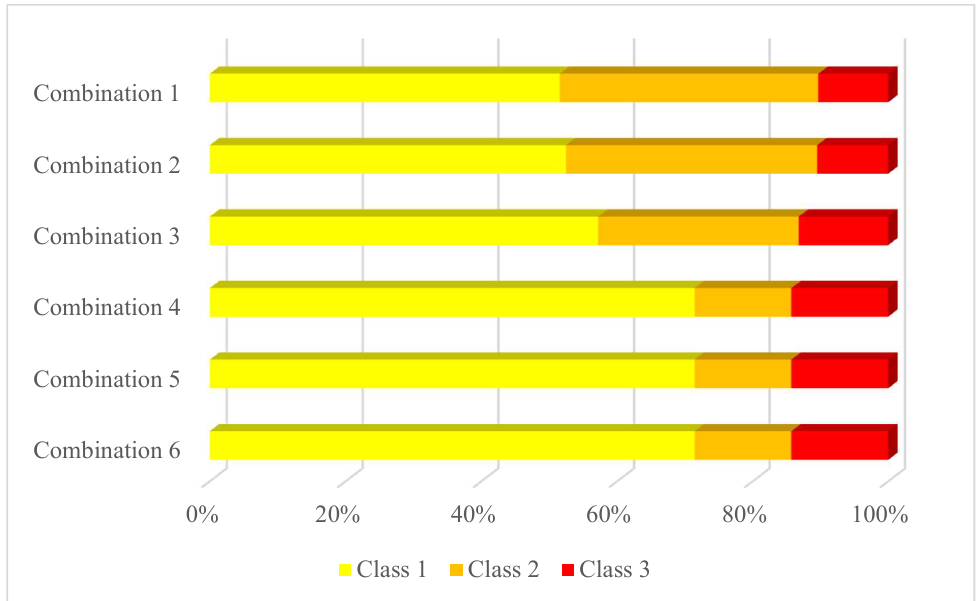
Figure 4. The proportion of classes in each method of categorizing.